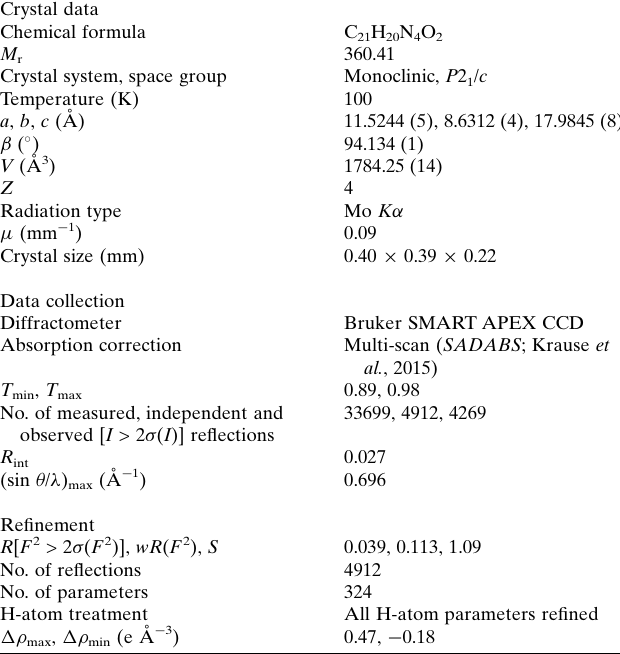
Crystal data Chemical